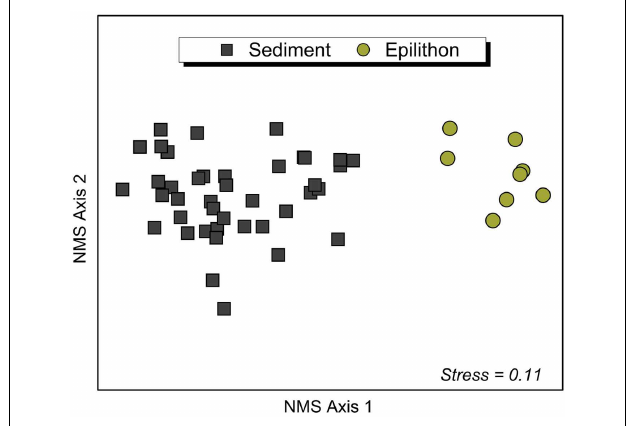
FIGURE 2 | Non-metric multidimensional scaling (NMS) ordination (first and second of the 3-dimensional solution) of stream sediment bacterial communities (left side, n = 42) and epilithon bacterial communities (right side, n = 8) based on pairwise similarity estimates (Bray–Curtis). Points that are close together represent communities with similar bacterial community composition based on theT-RFLP method.The associated normal stress value of the ordination is 0.11, indicating a good approximation of the overall structure of the data in multivariable space.